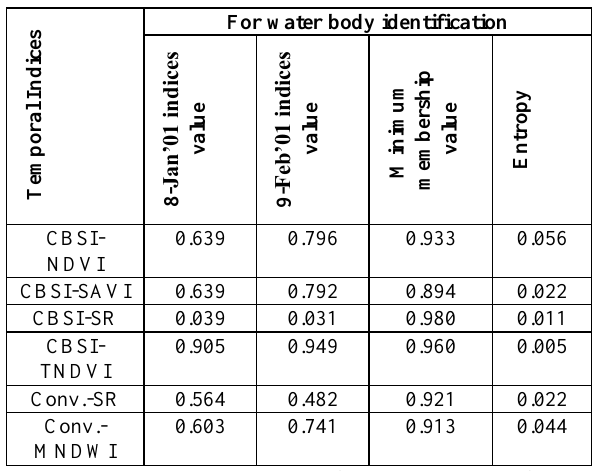
Table 2. Temporal indices results for water body identification The NDVI, SAVI, SR and TNDVI band ratio techniques were